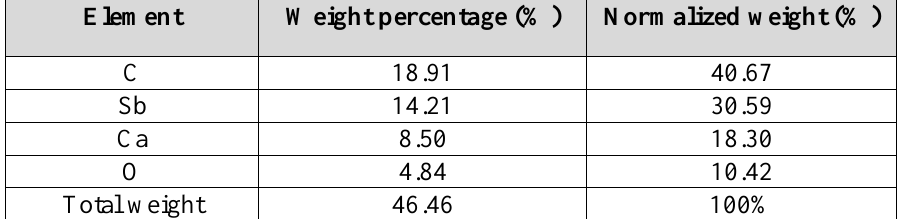
Table 5: The chemical composition of the industrial papers.